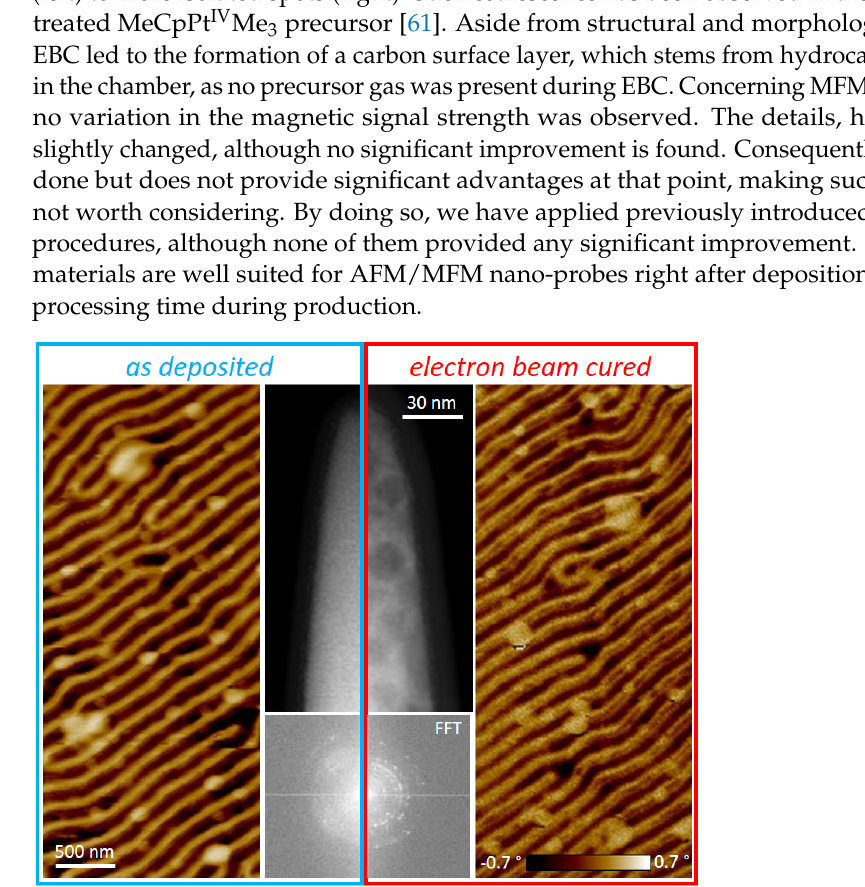
Figure 6. Impact of electron beam curing on Co 3 Fe α -pillars. Results (MFM phase, HAADF image, and Fast Fourier Transformation) of as-deposited tips are framed in blue, and the red box presents the results after curing. Scale and color bars apply for each image type.